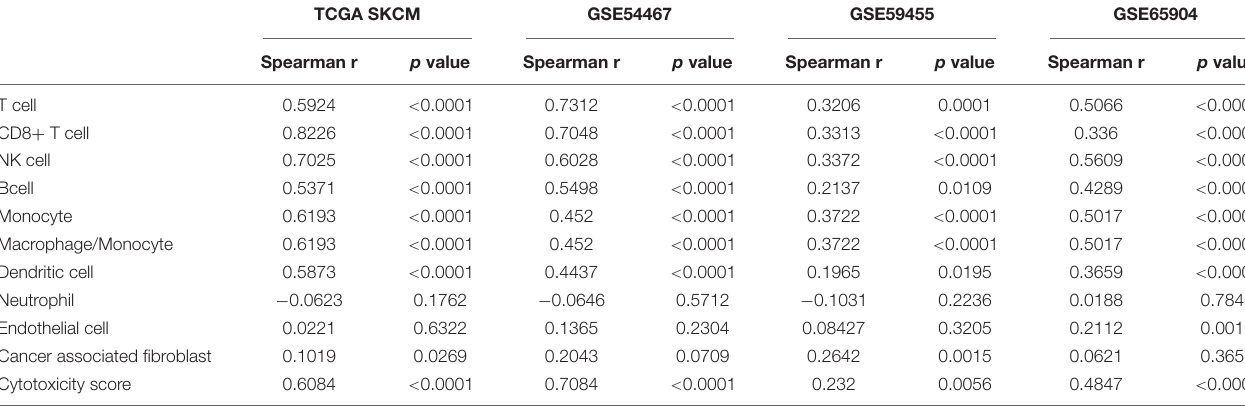
TABLE 2 | Correlation between NLRC5 expression and infiltrating level of immune cell estimated by “MCP-counter” in melanoma